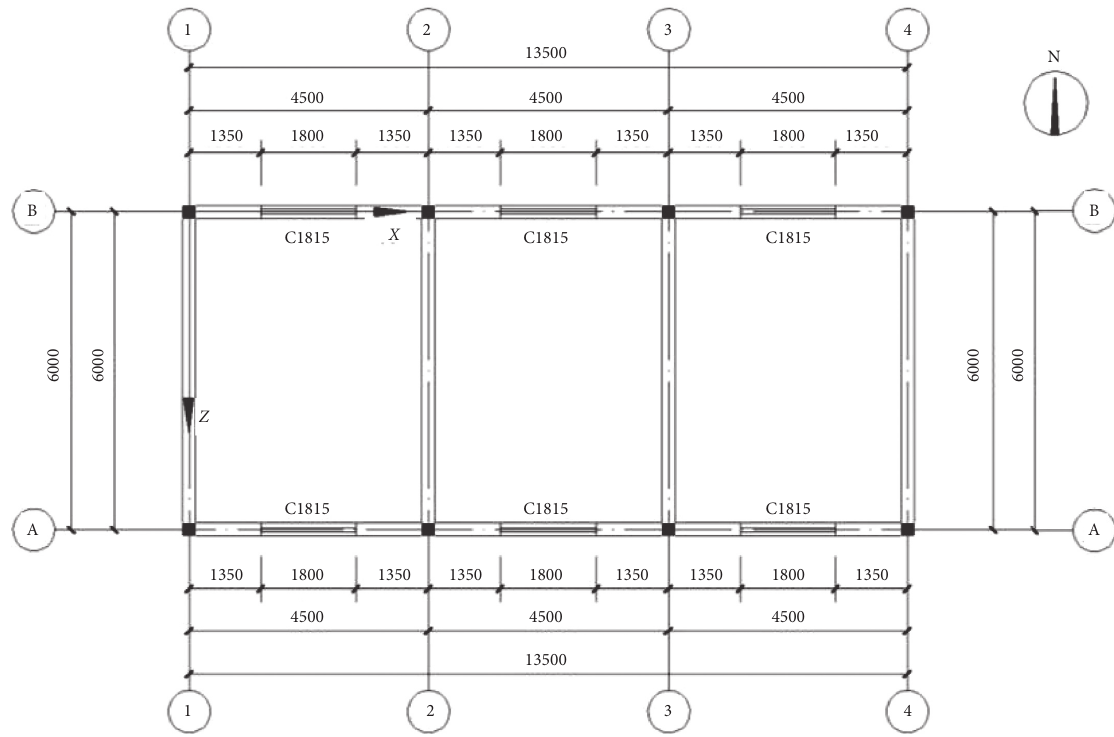
Figure 3: Layout of typical floor plan.